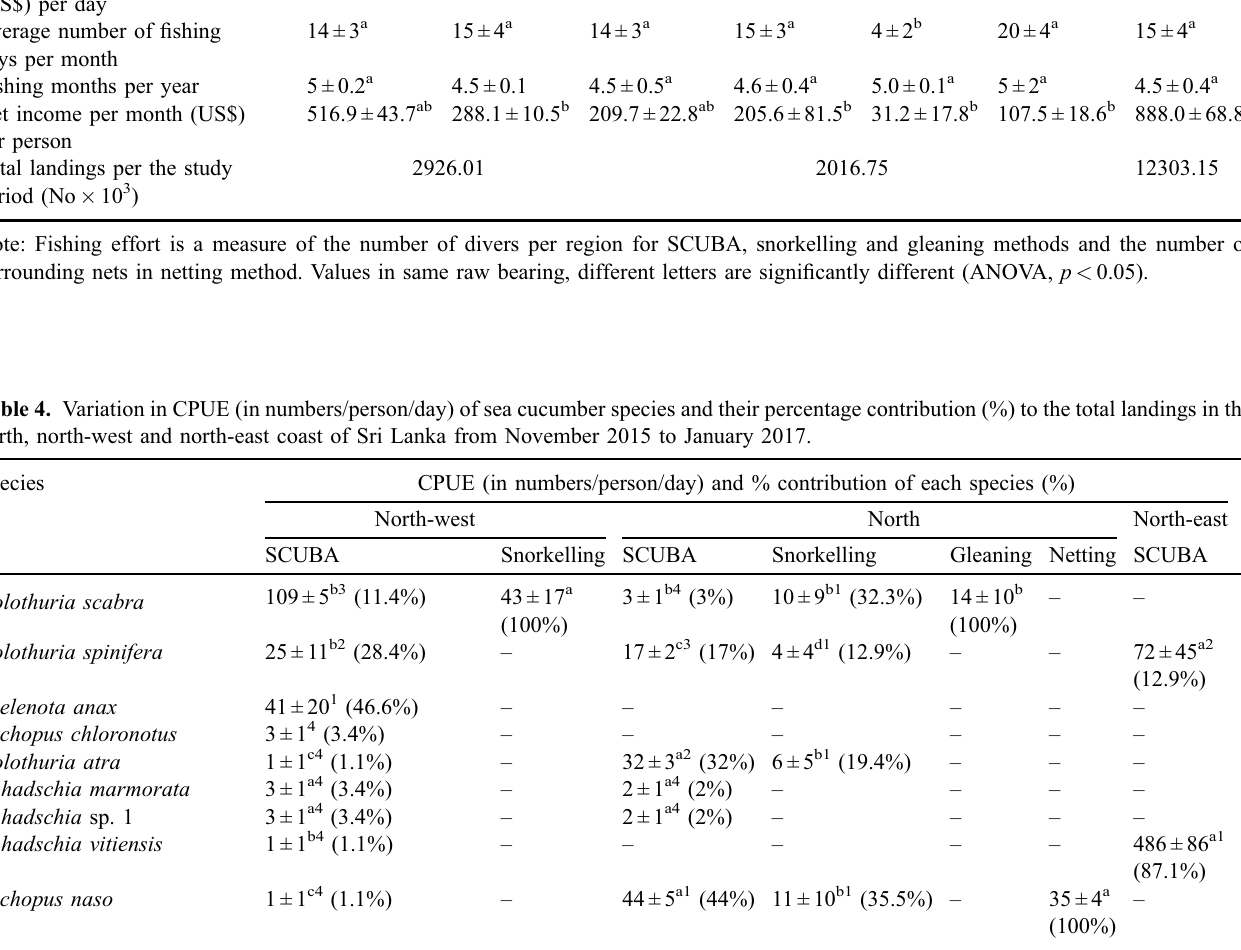
Note: Values in same raw bearing, different letters are signi fi cantly different and values in same column bearing, different numbers are signi fi cantly different (ANOVA, p < 0.05).